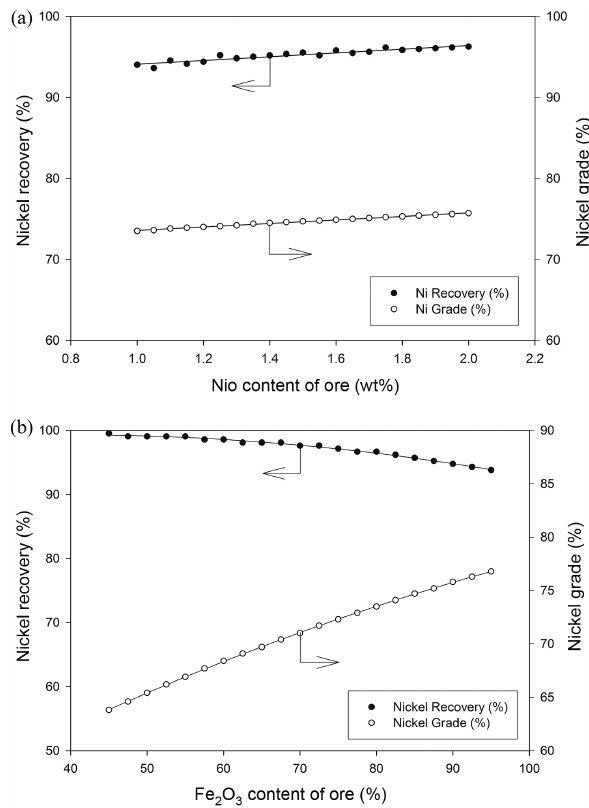
Figure 10: Effect of NiO content of the ore (a) and Fe 2 O 3 content of the ore (b) on the nickel recovery and nickel grade of the ferro- nickel for reduction of the calcined ore in hydrogen at a reductant to ore ratio of 0.558 kmol/100 kg and a reduction temperature